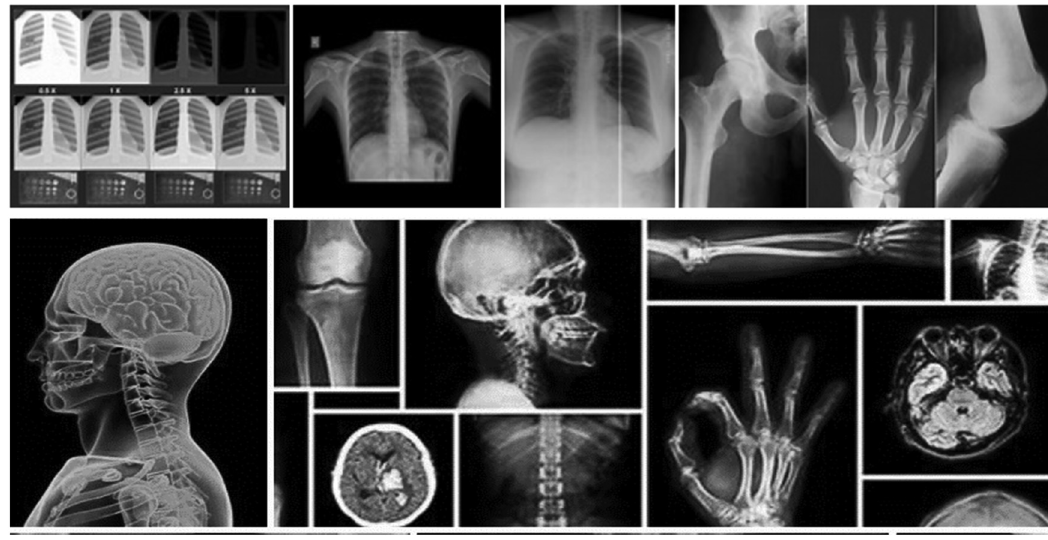
Figure 1: Sample medical radiography